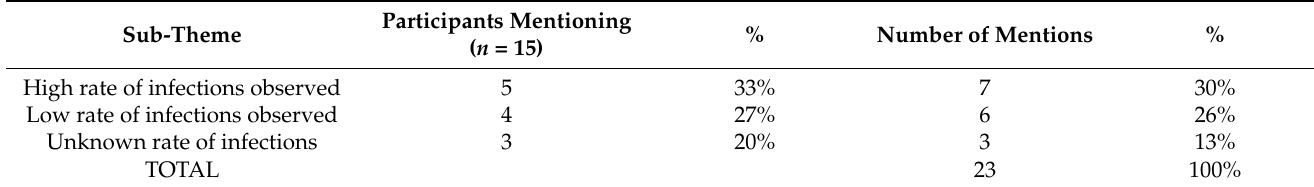
Table 1. Direct effects of the COVID-19 pandemic on assisted populations according to CSOs.